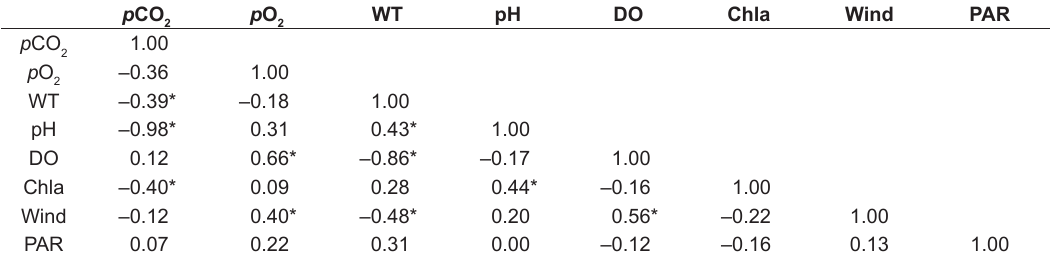
Figure 3. Diel and seasonal variation in p CO (May 23, 2010), winter (August 1, 2010), spring (September 30, 2010) and summer (January 13, 2011). Table 1. Spearman correlation of selected variables in Peri Lake along the period sampled. N= 28. Values with an asterisk are significant at